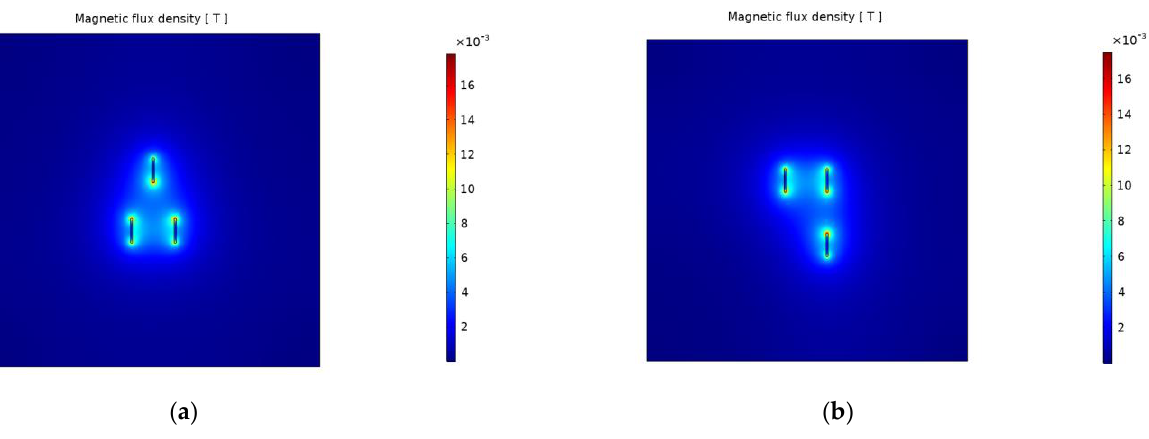
Figure 2. Layout of: ( a ) Model 1; ( b ) Model 2.